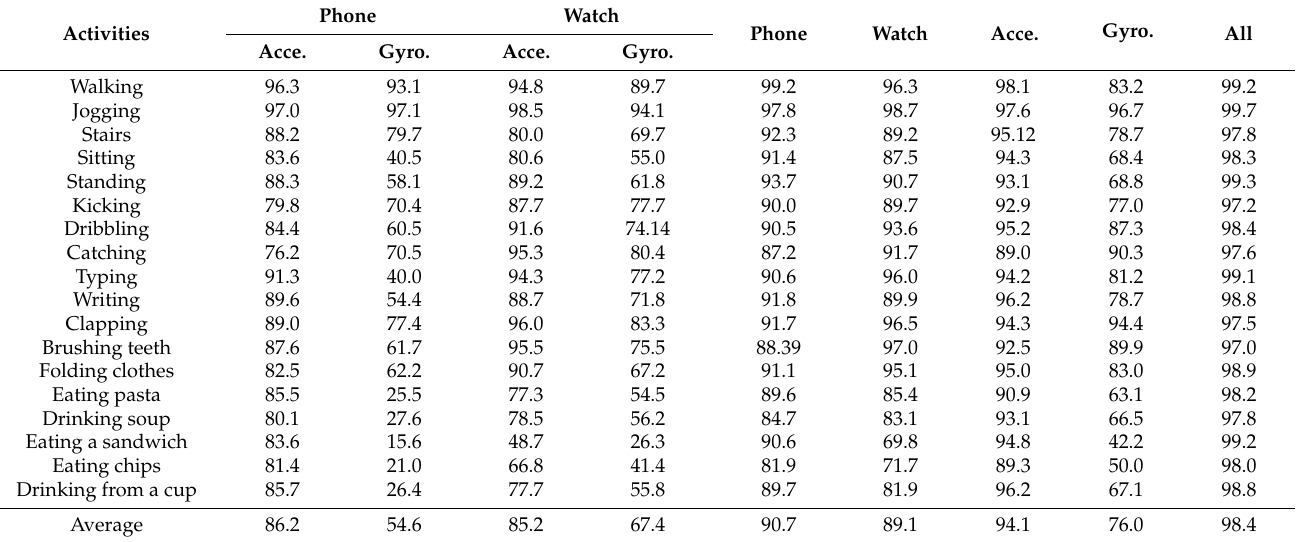
Table 10. F 1 -scores of 18 physical activities using the accelerometers and gyroscopes embedded in the smartphones and